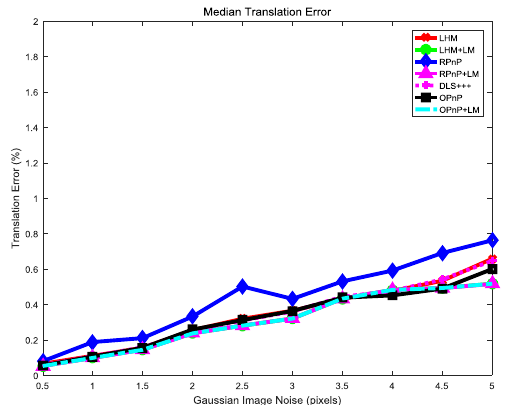
Figure 8. Median translation error w.r.t. varying noise